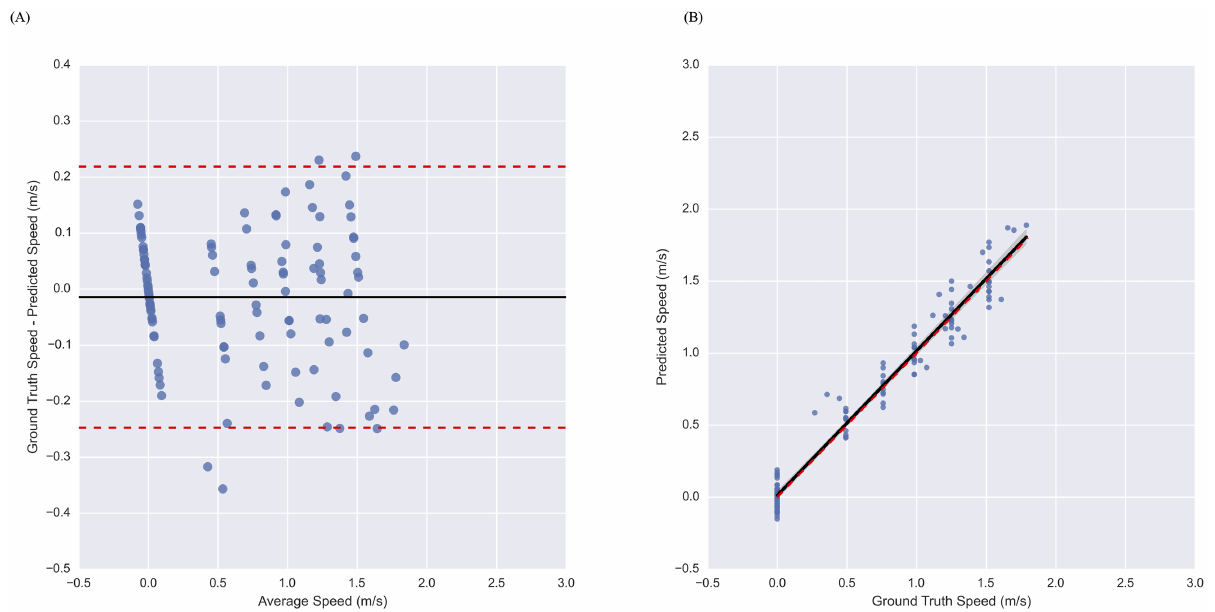
Fig 2. Performanceof model using sacrum, thigh, and shank device locations on treadmill data from healthy subjects. Bland- Altman (A) and regression(B) plots illustrating the performance of the accelerometer-based model for estimatingwalkingspeedon a treadmill. As illustratedin the plots, the model produces unbiased estimates of speedwith homoscedastic error.